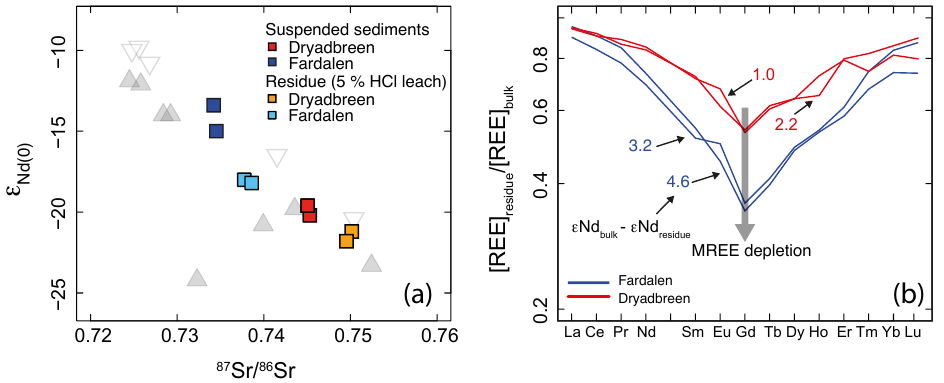
Figure 9. (a) ε Nd and 87 Sr / 86 Sr data for bulk stream suspended sediments and residual stream suspended sediments after leaching with 5% HCl. The grey symbols in the background are the data from Fig. 5. (b) Rare earth element (REE) abundances of the residue relative to the bulk phase. The greater the depletion in middle REE (MREE), the greater the difference in ε Nd between bulk and residual phases and this difference is most pronounced in the unglaciated catchment (Fardalen) where relative I/S abundances are higher compared to the glaciated catchment (Dryadbreen, Table 2). The residual phases have a lower ε Nd value compared to the bulk.